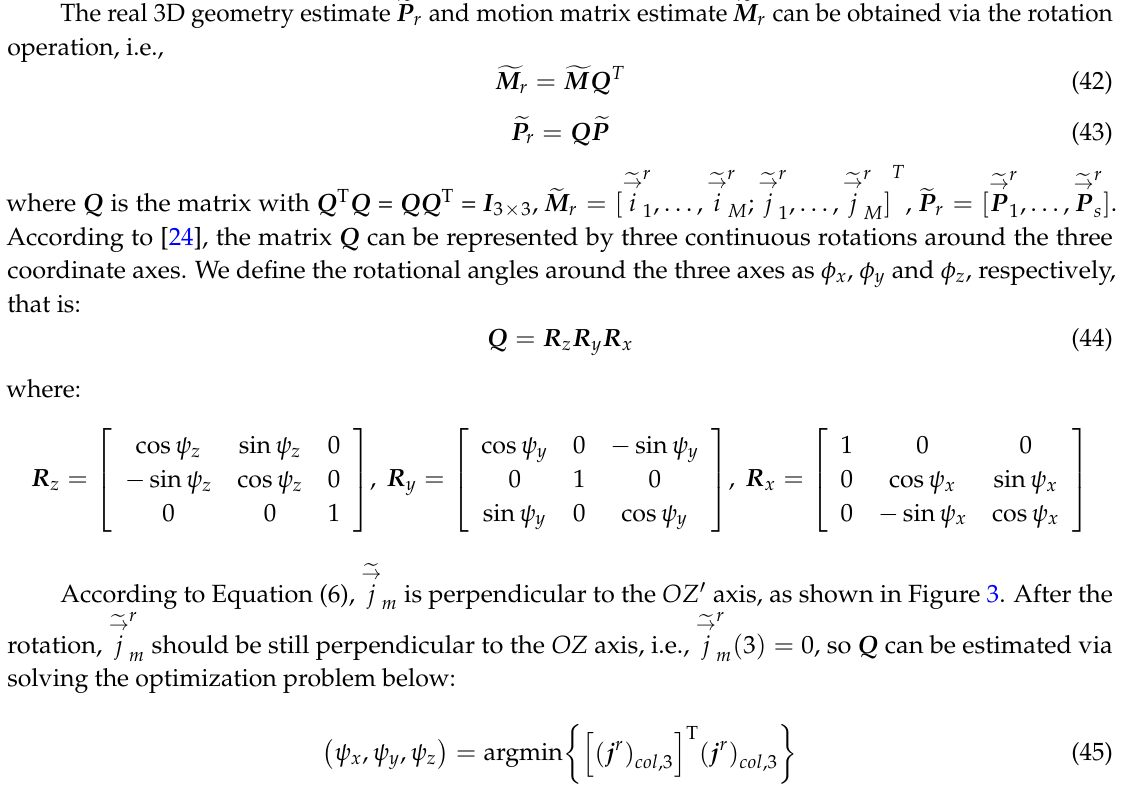
Figure 3. The new coordinate system O-X’Y’Z’ after 3D rotation.